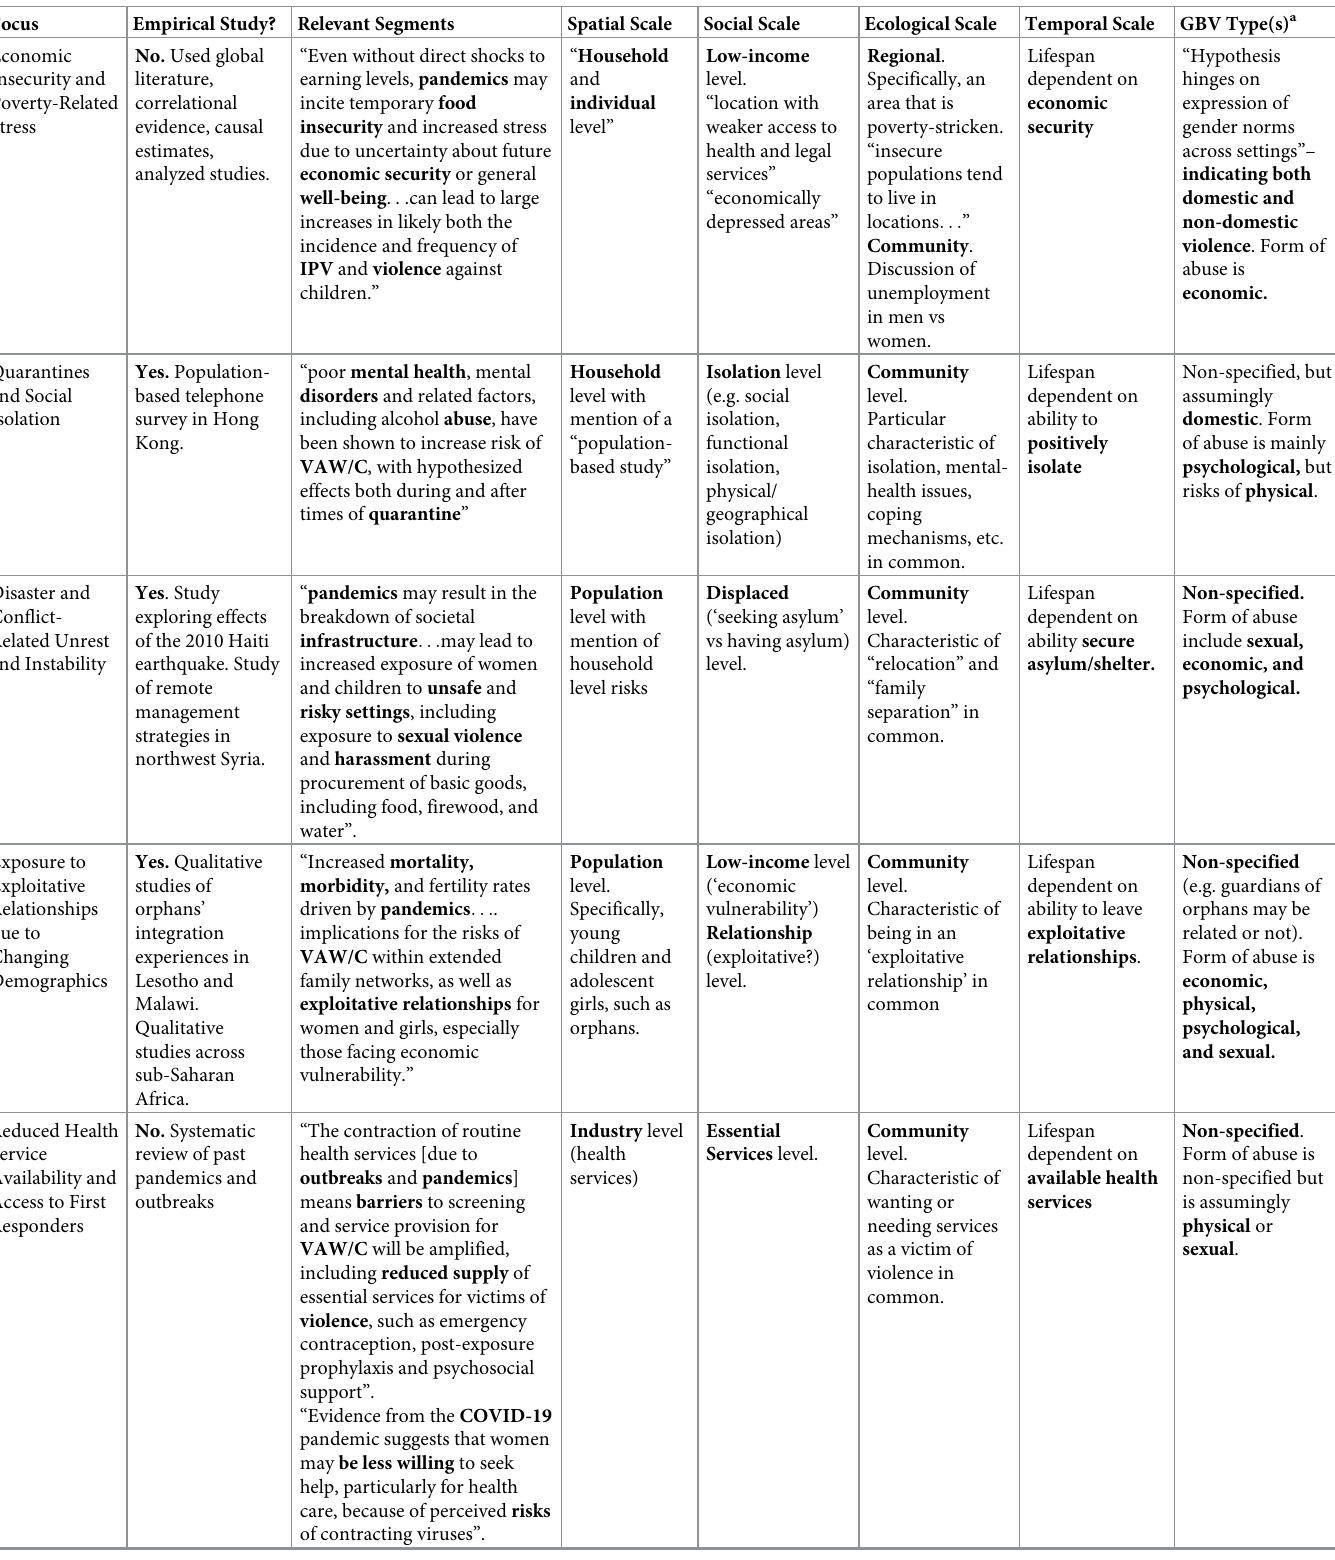
Table 2. Exemplar review article demonstrating the interrelationship between basic human needs (e.g., food security), pandemics (e.g., COVID-19), and gender- based violence (GBV)